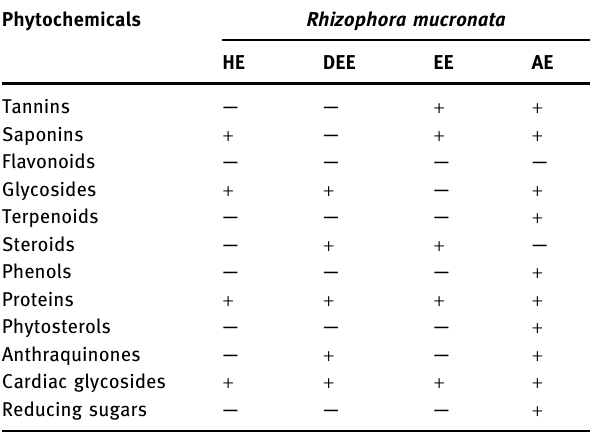
Table 1: Phytochemical screening of various solvent extracts of Rhizophora mucronata Phytochemicals